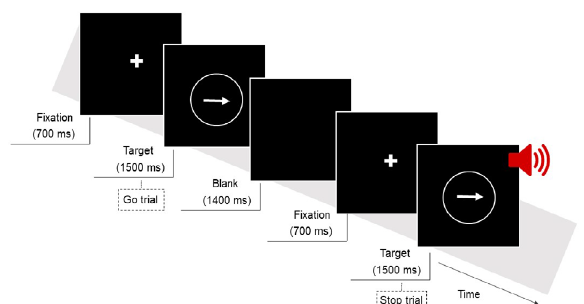
Figure 1. Experimental procedure of the stop-signal task. The task consisted of Go and Stop trials. All trials began with a central fixation cross and were followed by an arrow. Participants were required to press a key (i.e., either left or right depending on the orientation of the arrow). On 25% of the trials, an auditory containment signal would appear as a signal to withhold